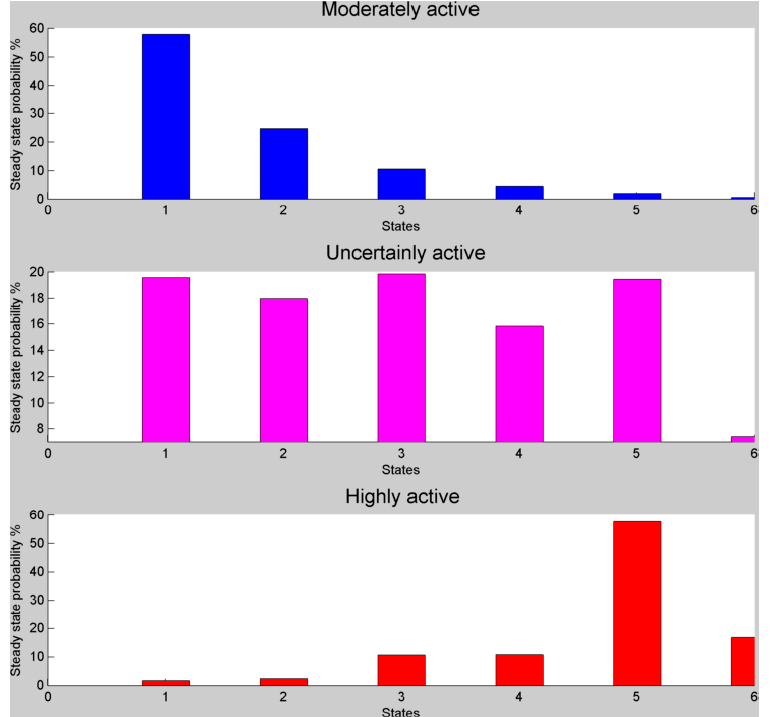
Figure 7. Steady state distribution of the different states under the three activity scenarios.